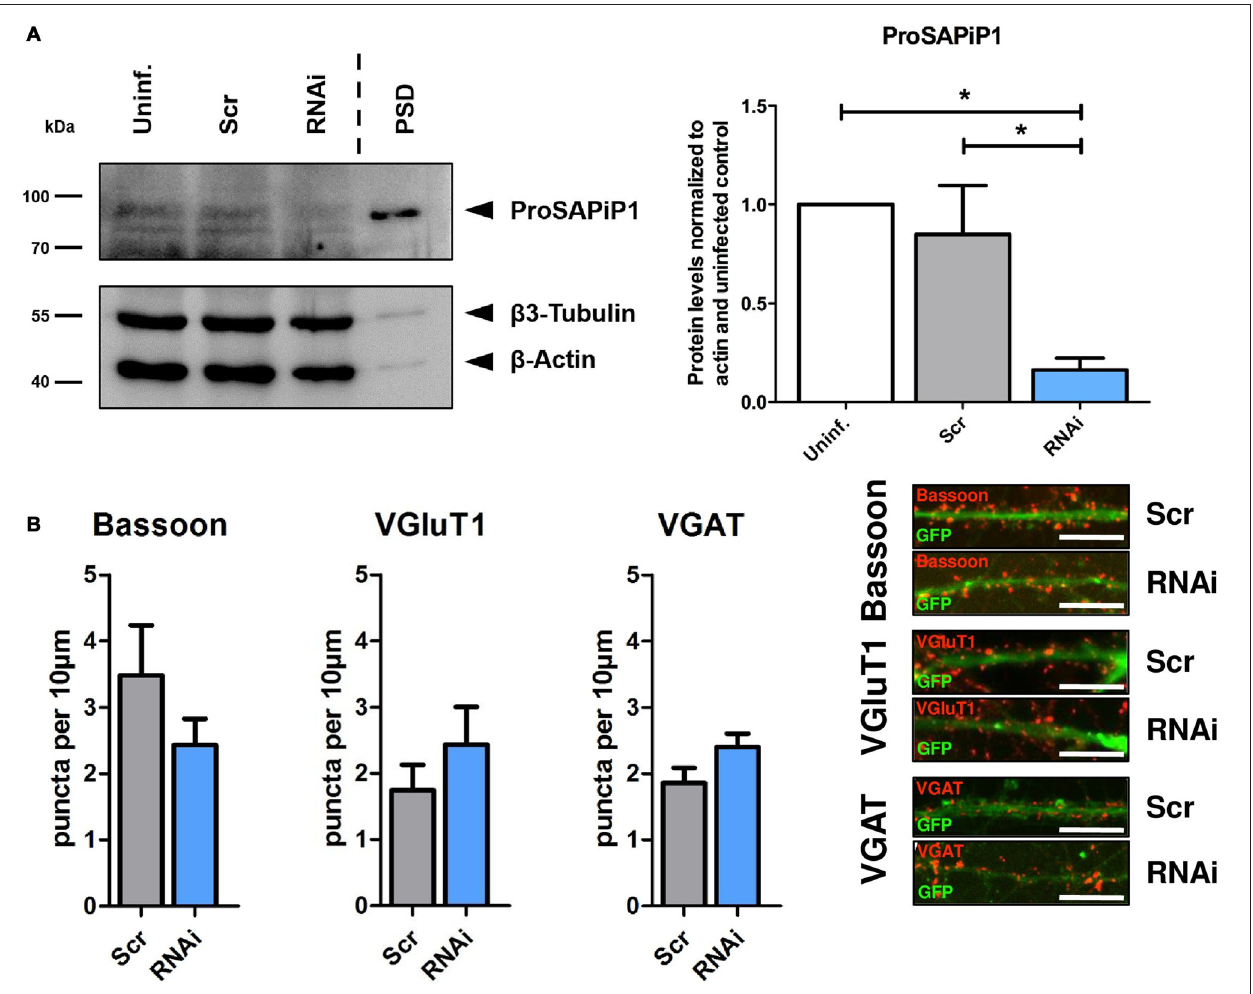
FIGURE 2 | Analysis of presynaptic specializations after ProSAPiP1 knockdown in mature primary hippocampal neurons. (A) RNAi based knockdown of ProSAPiP1 in primary hippocampal culture (RNAi) leads to a significant reduction of endogenous ProSAPiP1, whereas there are no differences between the uninfected (Uninf.) and the scrambled control (Scr). PSD from rat hippocampus was loaded as reference for endogenous ProSAPiP1. β 3-Tubulin and β -Actin serve as loading control. Statistical analysis was performed using One-way ANOVA. ∗ p < 0.05; n = 3 lysates from three independent cultures for each condition. (B) Infected (GFP, green) primary hippocampal cultures were stained on DIV28 for Bassoon (red), VGluT1 (red) or VGAT (red) as indicated. No significant differences were observed in the density of Bassoon, VGluT1 or VGAT positive puncta per 10 µ m dendrite length between Scr and RNAi. Scale bar: 10 µ m. Statistical analysis was performed using unpaired two-sided t -test. n = 15 neurons from three independent